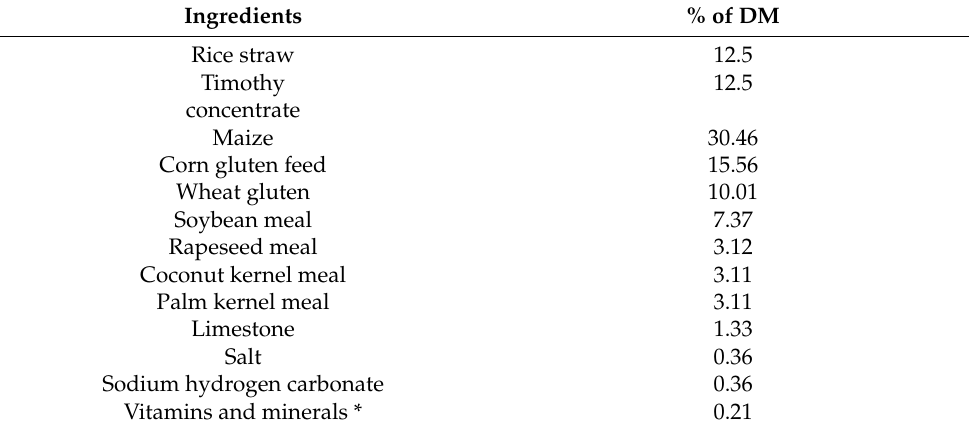
Table 1. Diet supplementation used in this